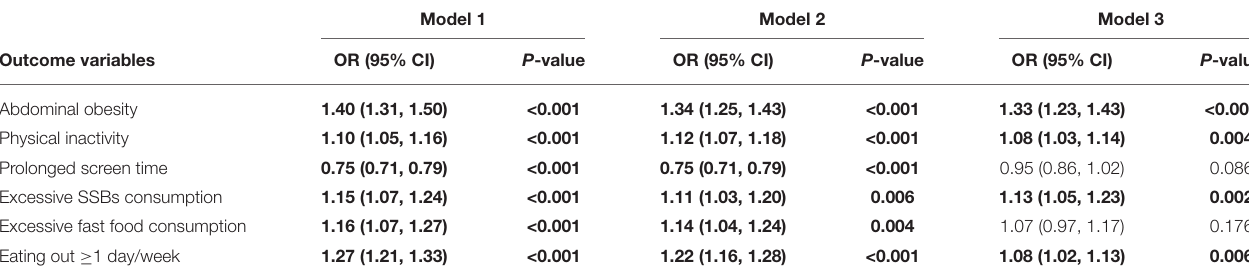
TABLE 2 | The associations between single-child status (single children vs. non-single children) and odds of abdominal obesity and unideal energy-related behaviors.